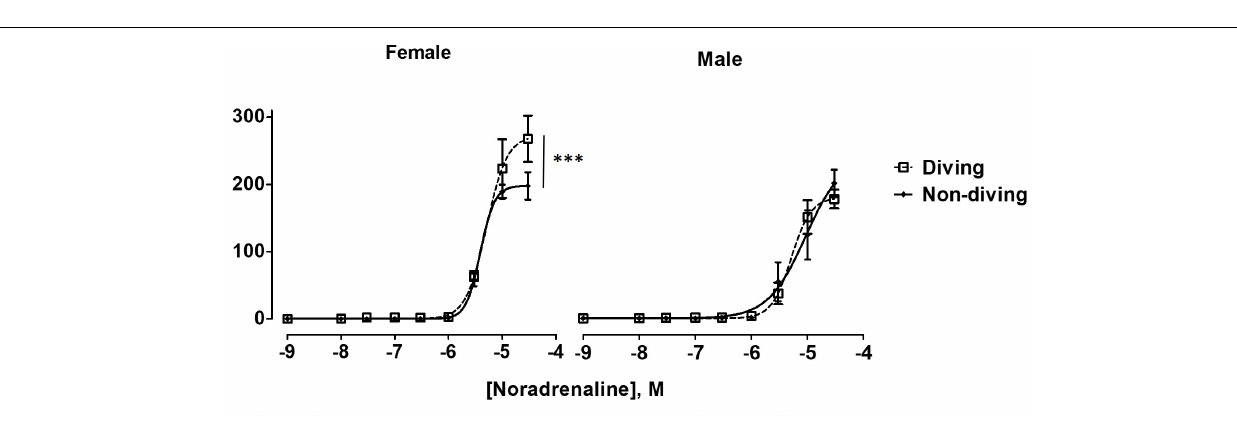
FIGURE 5 | Concentration-response curves to endothelial-independent relaxation by SNP in pulmonary arteries of ApoE KO rats, F test.